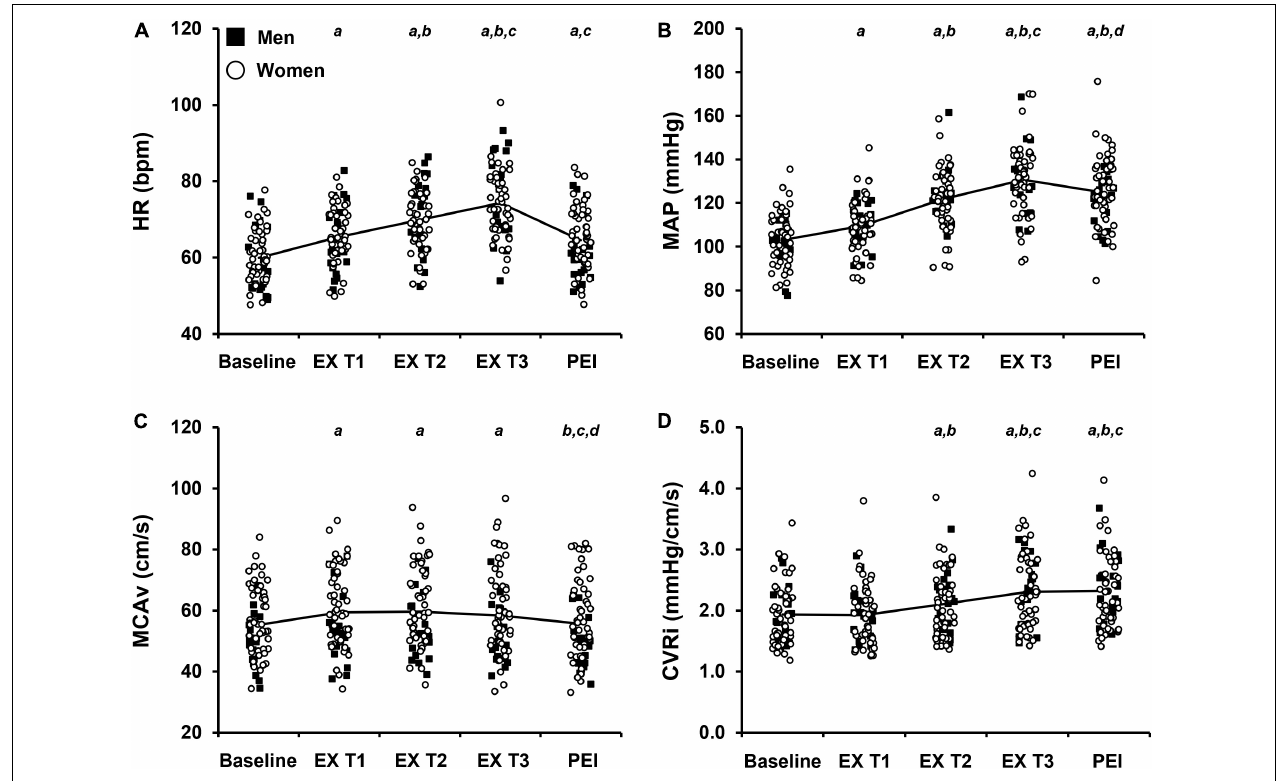
FIGURE 2 | Raw values of cardiovascular and cerebrovascular variables at baseline and during each tertile of isometric handgrip exercise (EX T1, EX T2, EX T3, respectively) followed by a period of post-exercise ischemia (PEI). Means and individual data presented. The solid black line represents mean values. (A) Heart rate, HR; (B) Mean arterial pressure, MAP; (C) Middle cerebral artery blood velocity, MCAv; (D) Cerebrovascular resistance index, CVRi. Significance is indicated by the following: a P < 0.05 vs. baseline, b P < 0.05 vs. exercise T1, c P < 0.05 vs. exercise T2, d P < 0.05 vs. exercise T3 (n = 68; One-way repeated measures ANOVA with Bonferroni post hoc